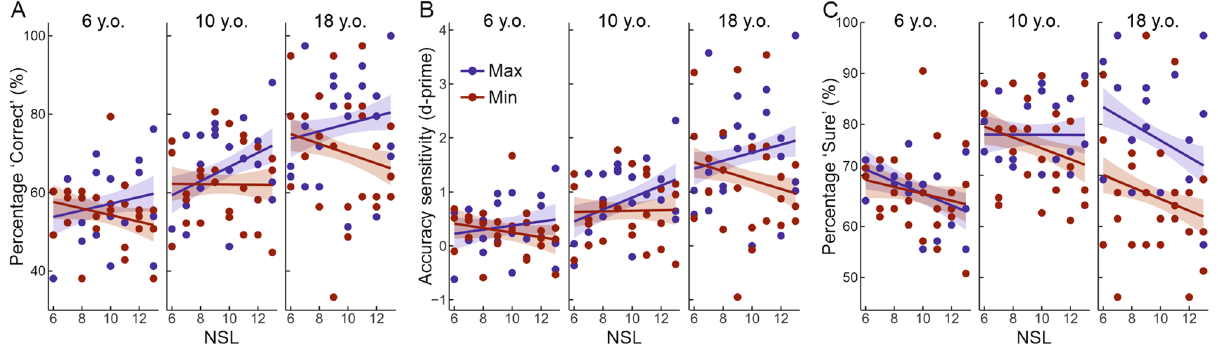
Figure 3. Scatterplots displaying the percentage of ‘Correct’ responses (panel A ), the accuracy sensitivity (panel B ), and the percentage of ‘Sure’ responses (panel C ) as a function of the “number of salient locations” (NSL) in the different age groups and target salience conditions. In all graphs, the coloured bands around the regression lines represent the standard error of the